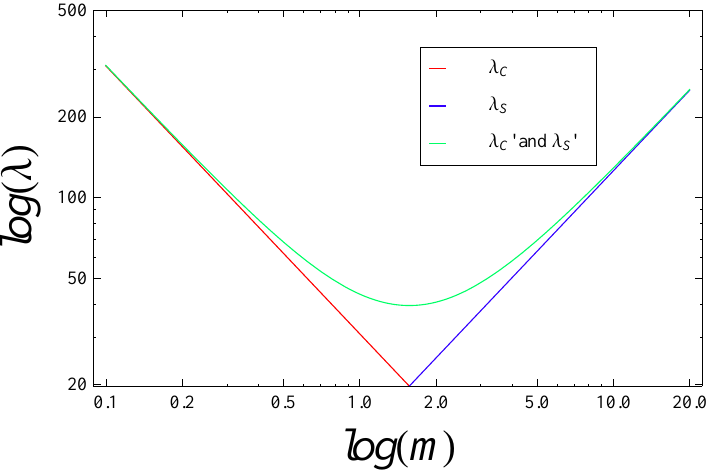
Figure 1. The Compton wavelength λ C ∝ 1/ m (red line) and Schwarzschild radius λ S ∝ m (blue line) as asymptotes to a unified radius λ (cid:48) (green curve) for objects with any rest mass C / S